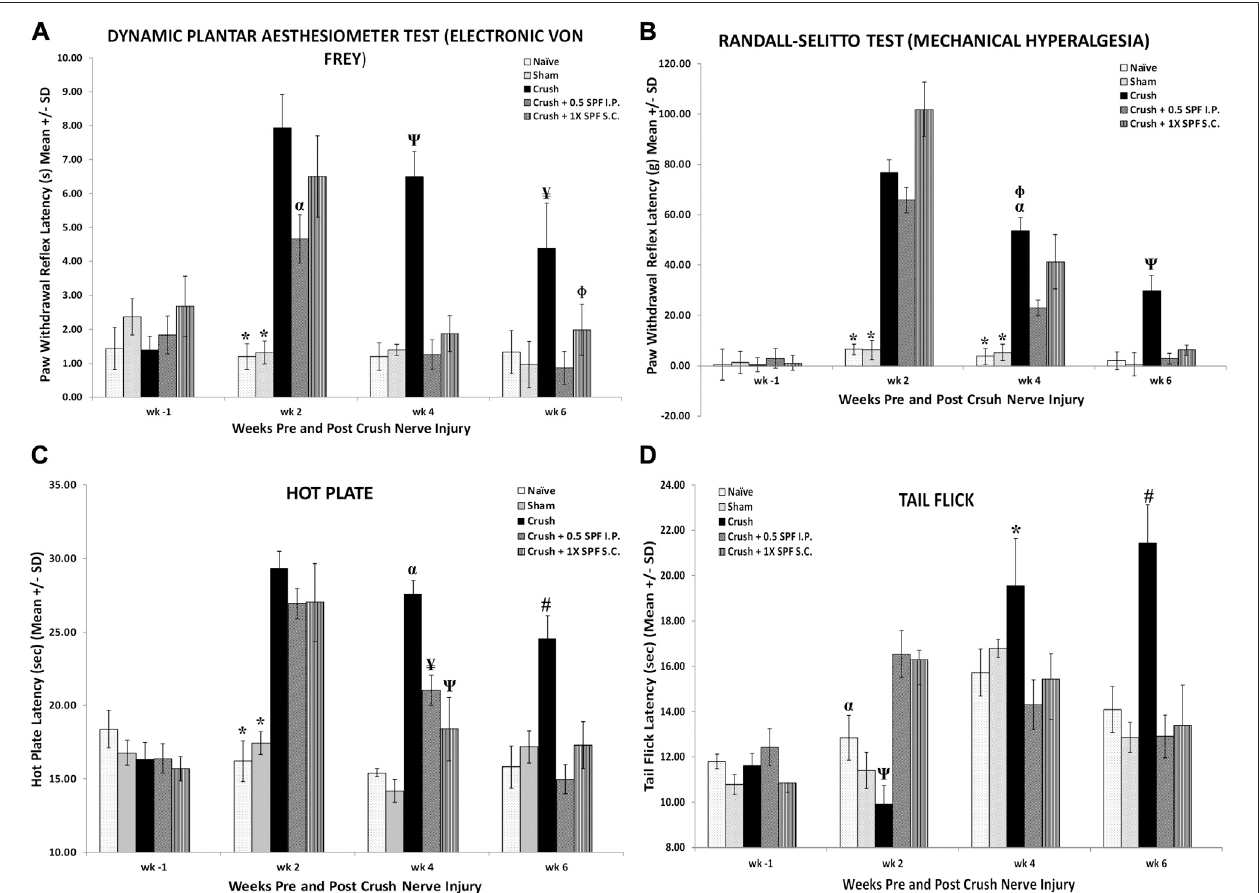
FIGURE2| ( A) :Bargraphsshowingtactileallodynia.TheCRUSHandtheCRUSH+SP-FB-treatedgroupsshowedasigni fi cantdecreaseinanalgesiaplantertest atweek1post-injury.Byweek3,theCRUSH,CRUSH+1XSPF-FB(S.C.)andCRUSH+1XSPF-FB(IP)groupsdisplayedanincreaseinanalgesia.However,CRUSH+ 0.5X SPF-FB (IP) group showed a signi fi cant decrease compared to CRUSH and CRUSH + SPF-FB S.C.-treated animals. The CRUSH + 0.5X SPF-FB (IP) stayed signi fi cantlydifferentfromtheCRUSHgroupatweek5followingnerveinjury.*indicates p < 0.0001NAÏVEandSHAMvs.CRUSH,CRUSH+0.5XSPF-FB(IP)and CRUSH + 1X SPF-FB (S.C.); α indicates p < 0.02 CRUSH + 0.5X SPF-FB (IP) vs. CRUSH; Ψ indicates p < 0.0001 CRUSH vs. NAÏVE, SHAM, and treated groups; Φ indicates p < 0.05CRUSH+1XSPF-FB(S.C.) vs.CRUSH;¥indicates p < 0.02CRUSHvs. NAÏVE, SHAMand CRUSH+0.5X SPF-FB(IP).( B) :TheCRUSH+SPF-FB- treated groups showed a signi fi cant decrease in paw withdrawal re fl ex latency periods compared with the CRUSH group at week 4. At week 6, CRUSH + 0.5X SPF- FB(IP)-treated animals displayed a signi fi cant decrease in paw pressure latency. * indicates p < 0.0001 NAÏVE and SHAM vs. Crush and treated groups; α indicates p < 0.0001 CRUSH vs. CRUSH + 0.5X SPF-FB (IP); Φ indicates p < 0.01 CRUSH vs. CRUSH + 1X SPF-FB (S.C.); Ψ indicates p < 0.0001 CRUSH vs. NAÏVE, SHAM and CRUSH + 0.5X SPF-FB (IP). (C) : Nerve crush injury produced a severe nociception de fi cit in the CRUSH and CRUSH-SPF-FB-treated groups at week two following nerve injury. The CRUSH- SPF-treated groups showed a signi fi cant thermal nociceptive recovery starting at Week 4. At Week 6 post-injury, the CRUSH + 0.5X SPF-FB (IP) animals maintained the thermal nociception recovery comparable to control groups. * indicates p < 0.0001 NAÏVE and SHAM vs. CRUSH and CRUSH + SPF-FB- treated groups; α indicates p < 0.0001 CRUSH vs. NAÏVE, SHAM and CRUSH + SPF-treated groups; ¥ indicates p < 0.005 CRUSH + 0.5X SPF-FB(IP) vs. SHAM and CRUSH; Ψ indicates p < 0.01 CRUSH + 1X SPF-FB(S.C.) vs. NAÏVE and SHAM groups; # indicates p < 0.001CRUSH vs. NAÏVE, SHAM and treated groups. (D) : The CRUSH + 0.5X SPF-FB-treated group showed signi fi cant tail- fl ick withdrawal latency recovery compared CRUSH group by the end of week 4 post-surgery. This nociception normalization was sustained until the end of the experiment, whereas CRUSH animals continued to display a signi fi cant increase in the tail- fl ick withdrawal latency compared to controls and SPF-FB-treated groups. * indicates p < 0.01 CRUSH vs. all groups; α indicates p < 0.01 SHAM vs. CRUSH + 0.5X SPF-FB(IP) and CRUSH+1XSPF-FB(S.C.); Ψ indicates p < 0.001CRUSHvs.CRUSH+SPF-FB-treatedgroups;#indicates p < 0.0001CRUSHvs.allgroups.Allvaluesareexpressed as means ± SDs (error